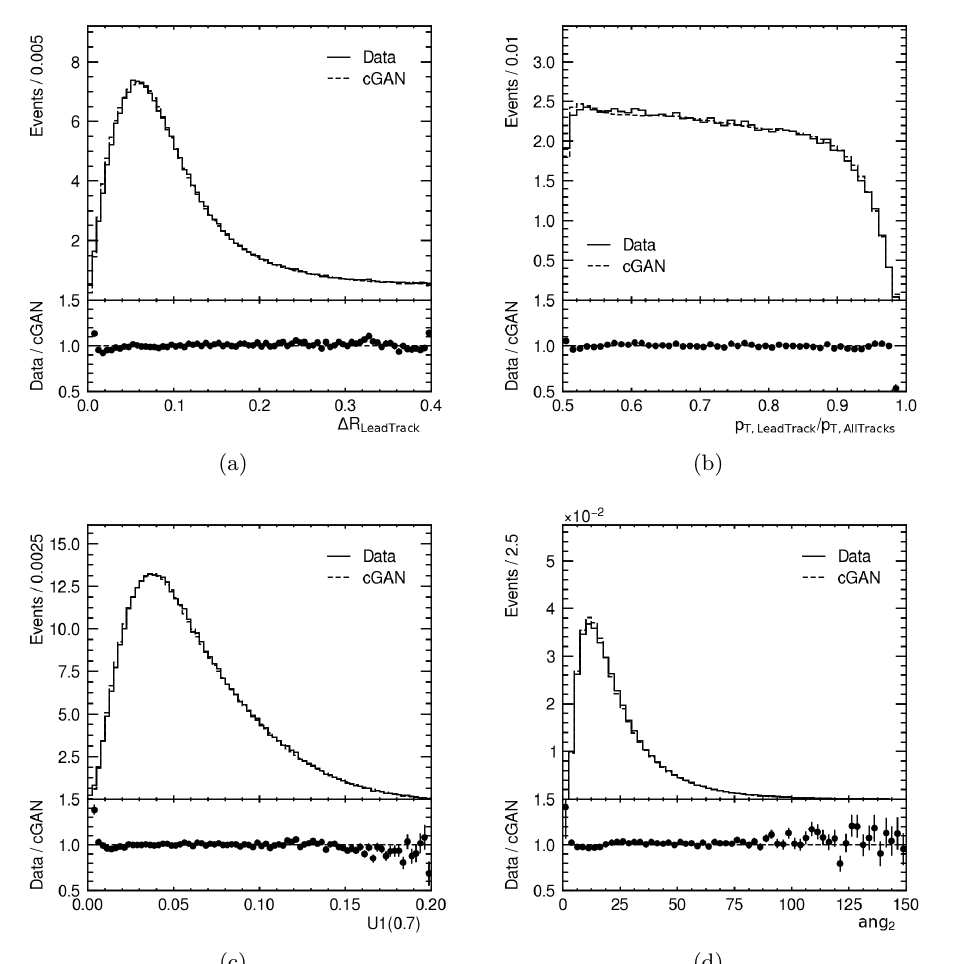
Figure 12 . Jet substructure variables in mock data and modelled by the cGAN, which are used as inputs to the classification MLP. The error bars on the markers in the lower panels represent the statistical uncertainty on the mock